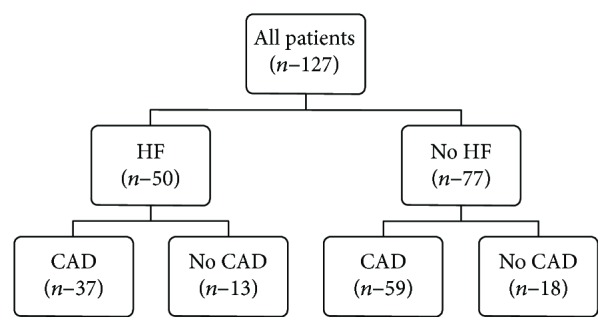
Subgroups of patients. HF: heart failure; No HF: heart failure absent; CAD: coronary artery disease present; No CAD: coronary artery disease absent.